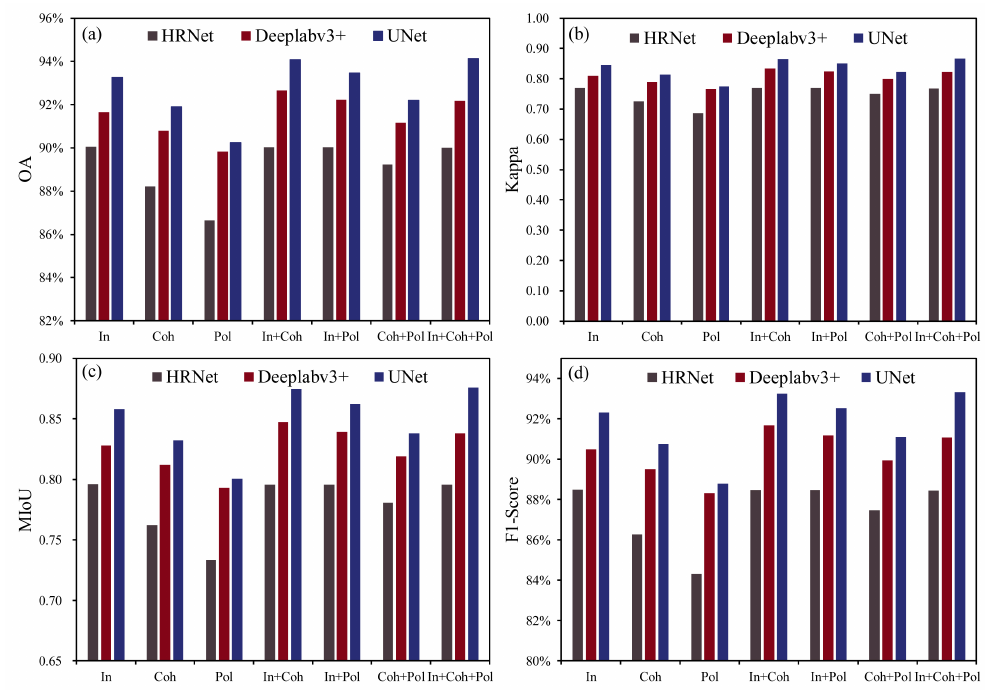
Figure 12. Comparison of impervious surface extraction accuracies of UNet, Deeplabv3+, and HRNet. ( a ) OA; ( b ) Kappa; ( c ) MIoU; ( d )